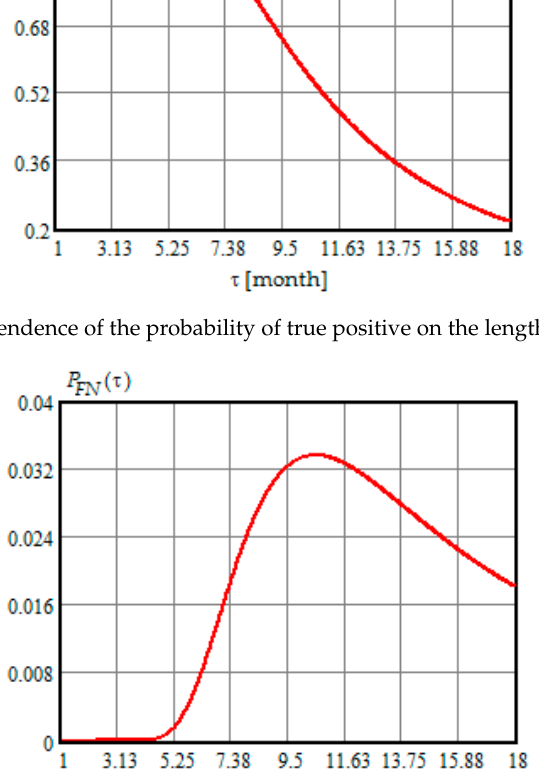
Figure 8. The dependence of the probability of false negative on the length of the interval τ .